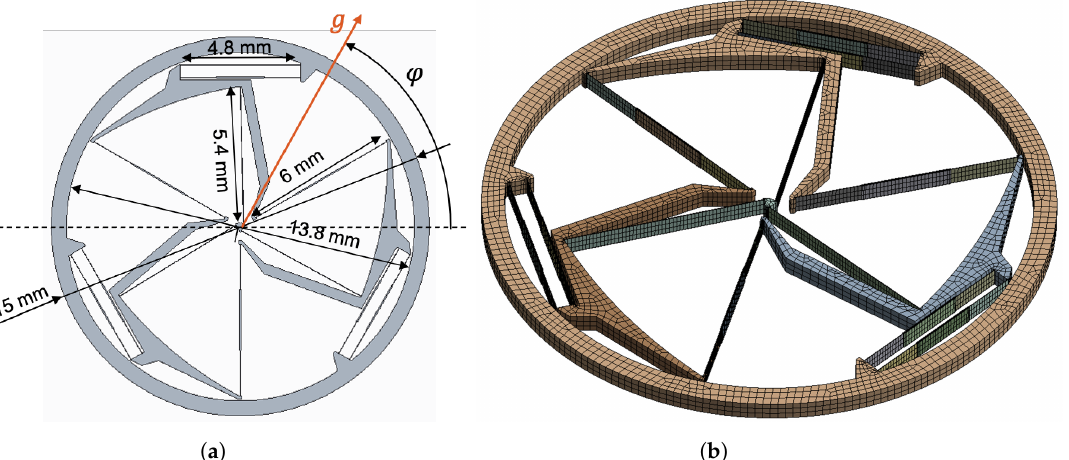
Figure 3. Watch-scale silicon TRIVOT oscillator design: ( a ) main dimensions, ( b ) finite element